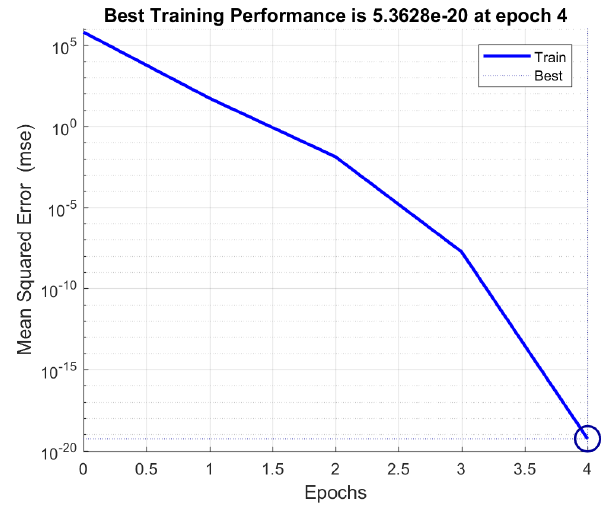
Figure 11. The ANN training performance curve.